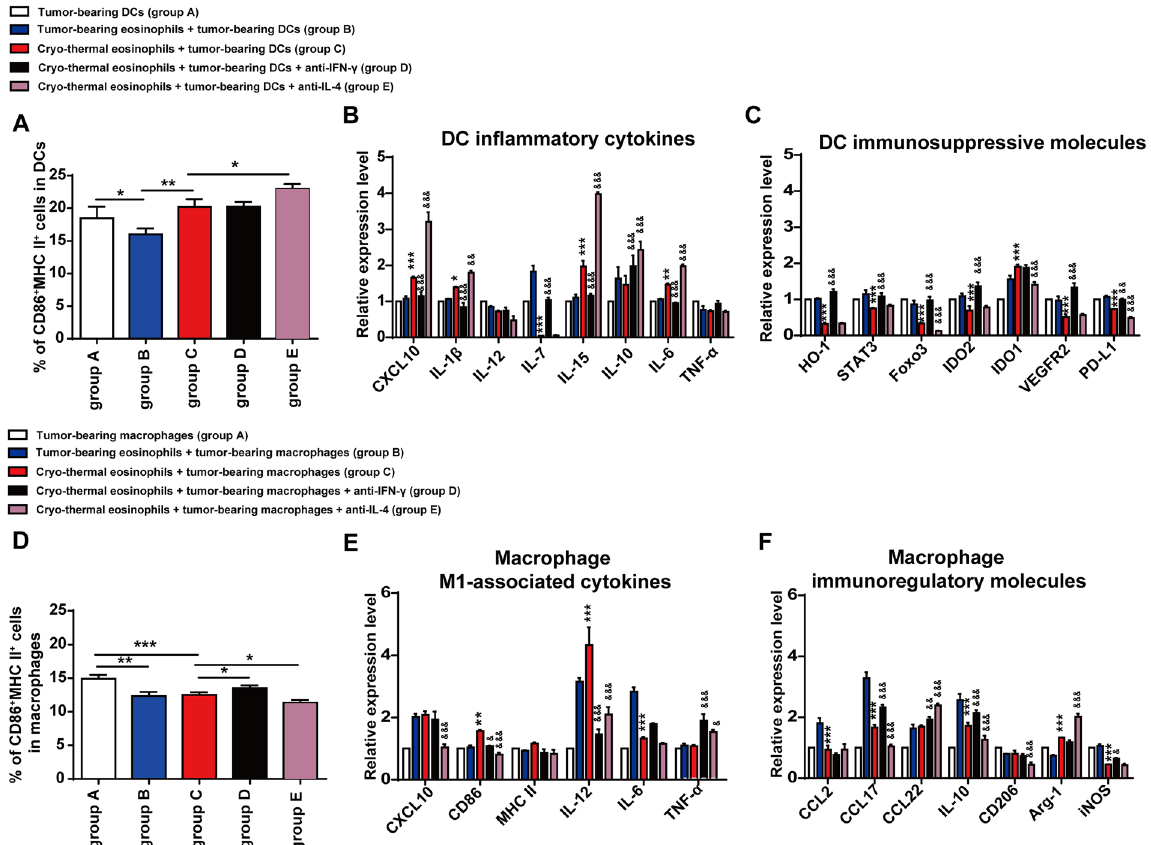
Figure 5. Cryo-thermal-activated eosinophils modulated the phenotype and function of macrophages and DCs by IL-4 and IFN- γ in vitro . ( A ) The percentage of CD86 + MHC II + cells in CD11c + DCs after co-cultured with eosinophils were analyzed by flow cytometry. The tumour-bearing CD11c + DCs were used as control. ( B , C ) Total RNA was isolated from CD11c + DCs after co-cultured with eosinophils and RT-qPCR analysis was performed to measure the level of pro-inflammatory cytokines and immunosuppressive molecules. ( D ) The percentage of CD86 + MHC II + cells in F4/80 + macrophages after co-cultured with eosinophils were analyzed by flow cytometry. The tumour-bearing macrophages were used as control. ( E , F ) Total RNA was isolated from macrophages after co-cultured with eosinophils and RT-qPCR analysis was performed to measure the level of M1-associated cytokines and immunoregulatory molecules. Data was shown as mean ± SD. Data for bar graphs was calculated using student’s t-test ( A , D ) or two-way ANOVA ( B , C , E , F ). * p < 0.05; ** p < 0.01; *** p < 0.001 was considered to be statistically significant compared to that in tumour-bearing eosinophils + tumour-bearing DCs/macrophage group ( B , C , E , F ). & p < 0.05; && p < 0.01; *** p < 0.001 was considered to be statistically significant compared to that in cryo-thermal eosinophils + tumour-bearing DCs/macrophage group ( B , C , E , F